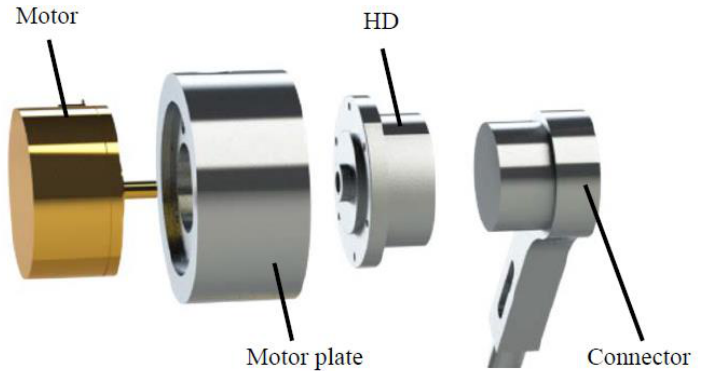
Figure 7. Hip joint design of the LLRE-II.